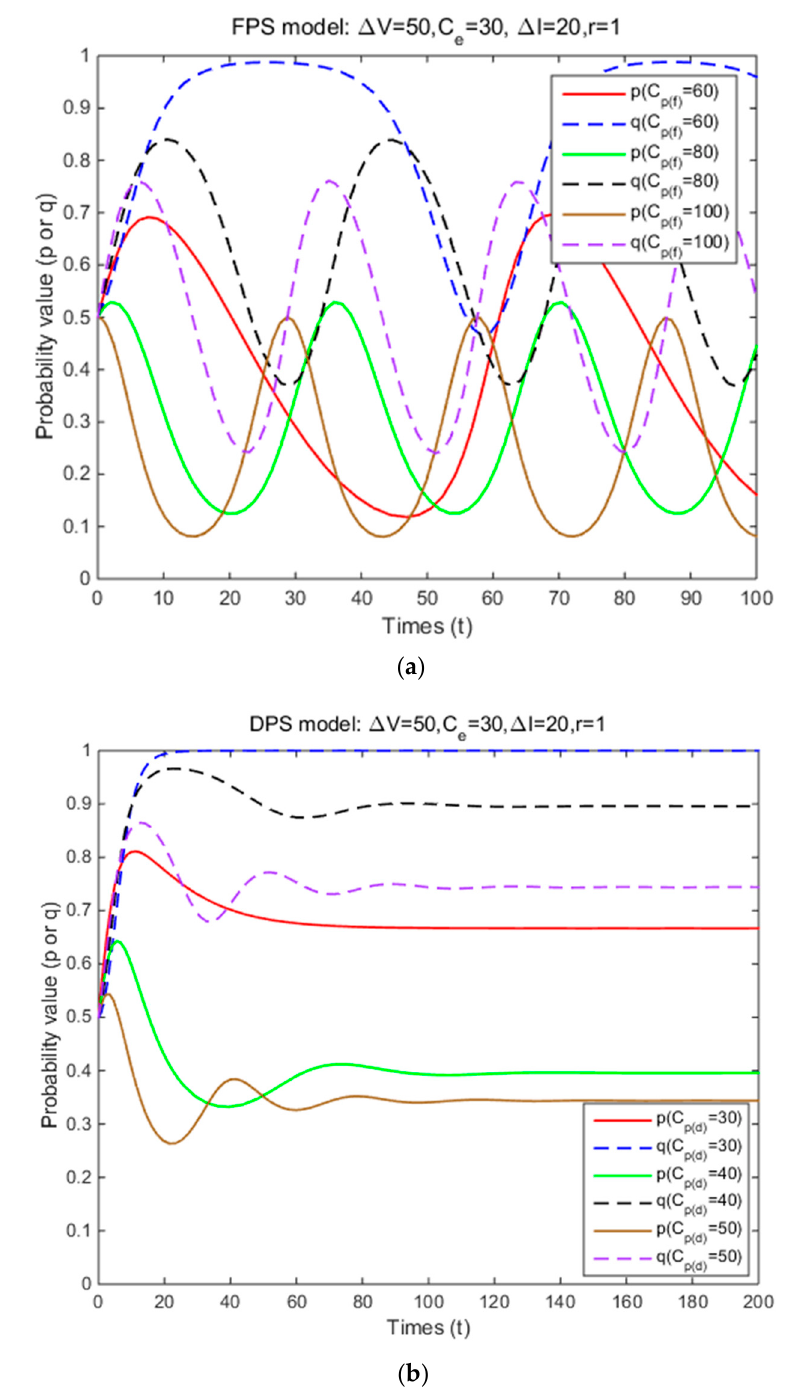
Figure 1. The effects of penalty amount on strategy probabilities of cyclists and law enforcement under FPS ( a ) and DPS ( b ) (Situation 3).